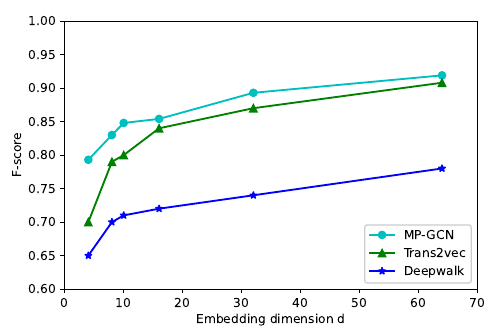
Figure 7. Fscore of the classification.